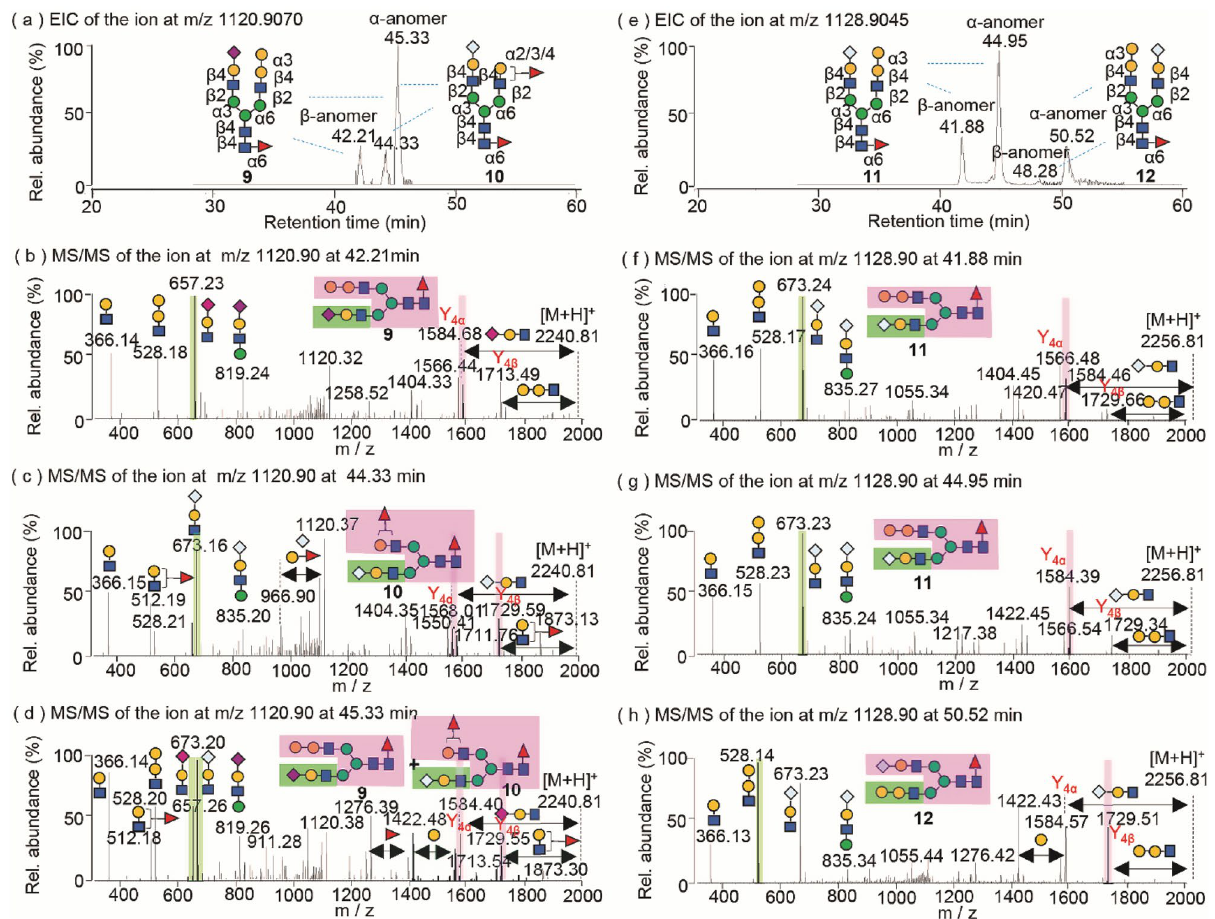
Figure 5. Cetuximab sialoglycan isomers containing di-terminal α-Gal and Neu5Gc. ( a , e ) EICs of the doubly charged ions of m/z 1120.9070 and m/z 1128.9045; ( b – d , f – h ) MS/MS spectra of the glycan ions of m/z 1120.90 and m/z 1128.90,